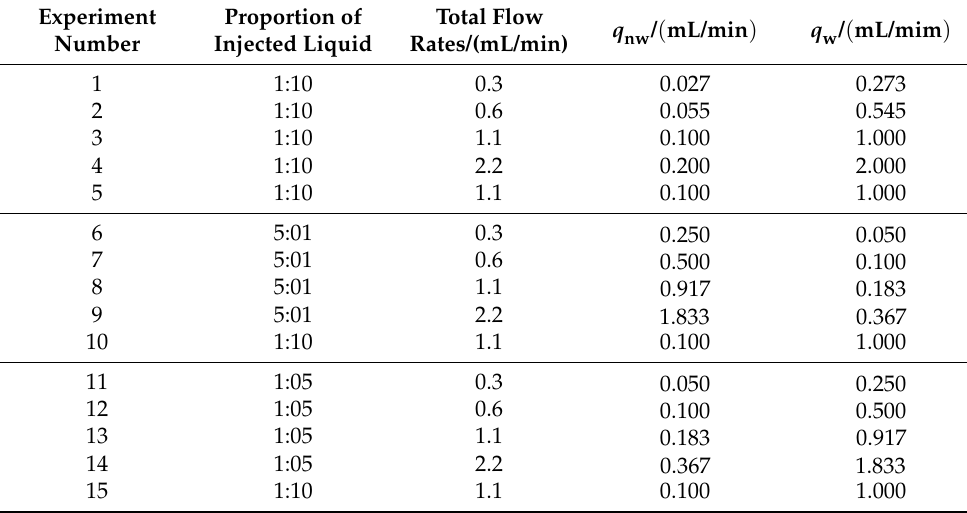
Table 4. Experimental design table.